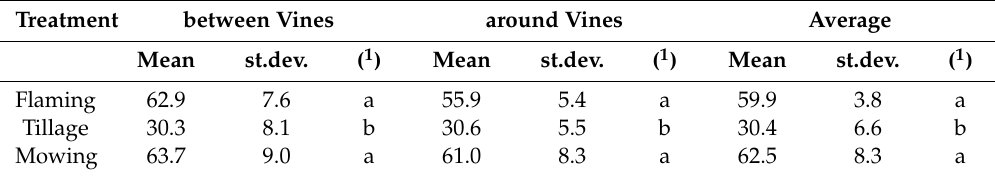
Table 3. E ff ect of the disc cultivator: aboveground biomass (g d.m. / m 2 ) on 8 May. Treatment between Vines around Vines Average Mean